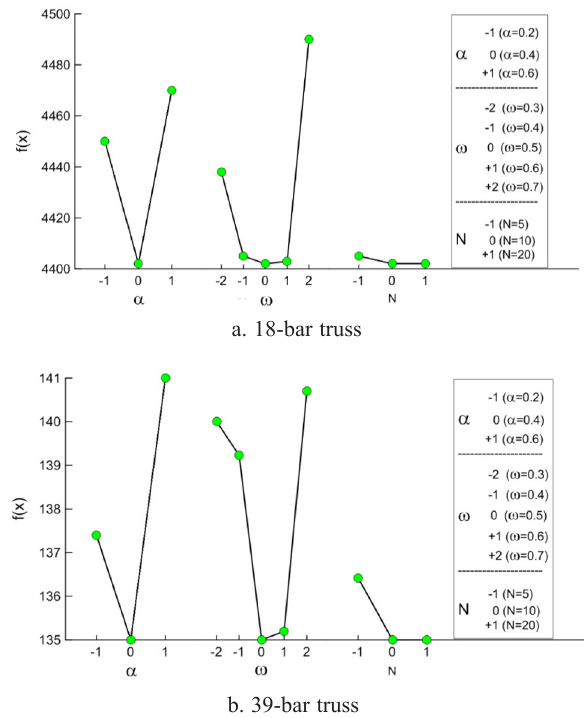
algorithmb. 39-bar truss Fig. 1. Illustrative results of the sensitivity analysis for the internal parameters of iPSO